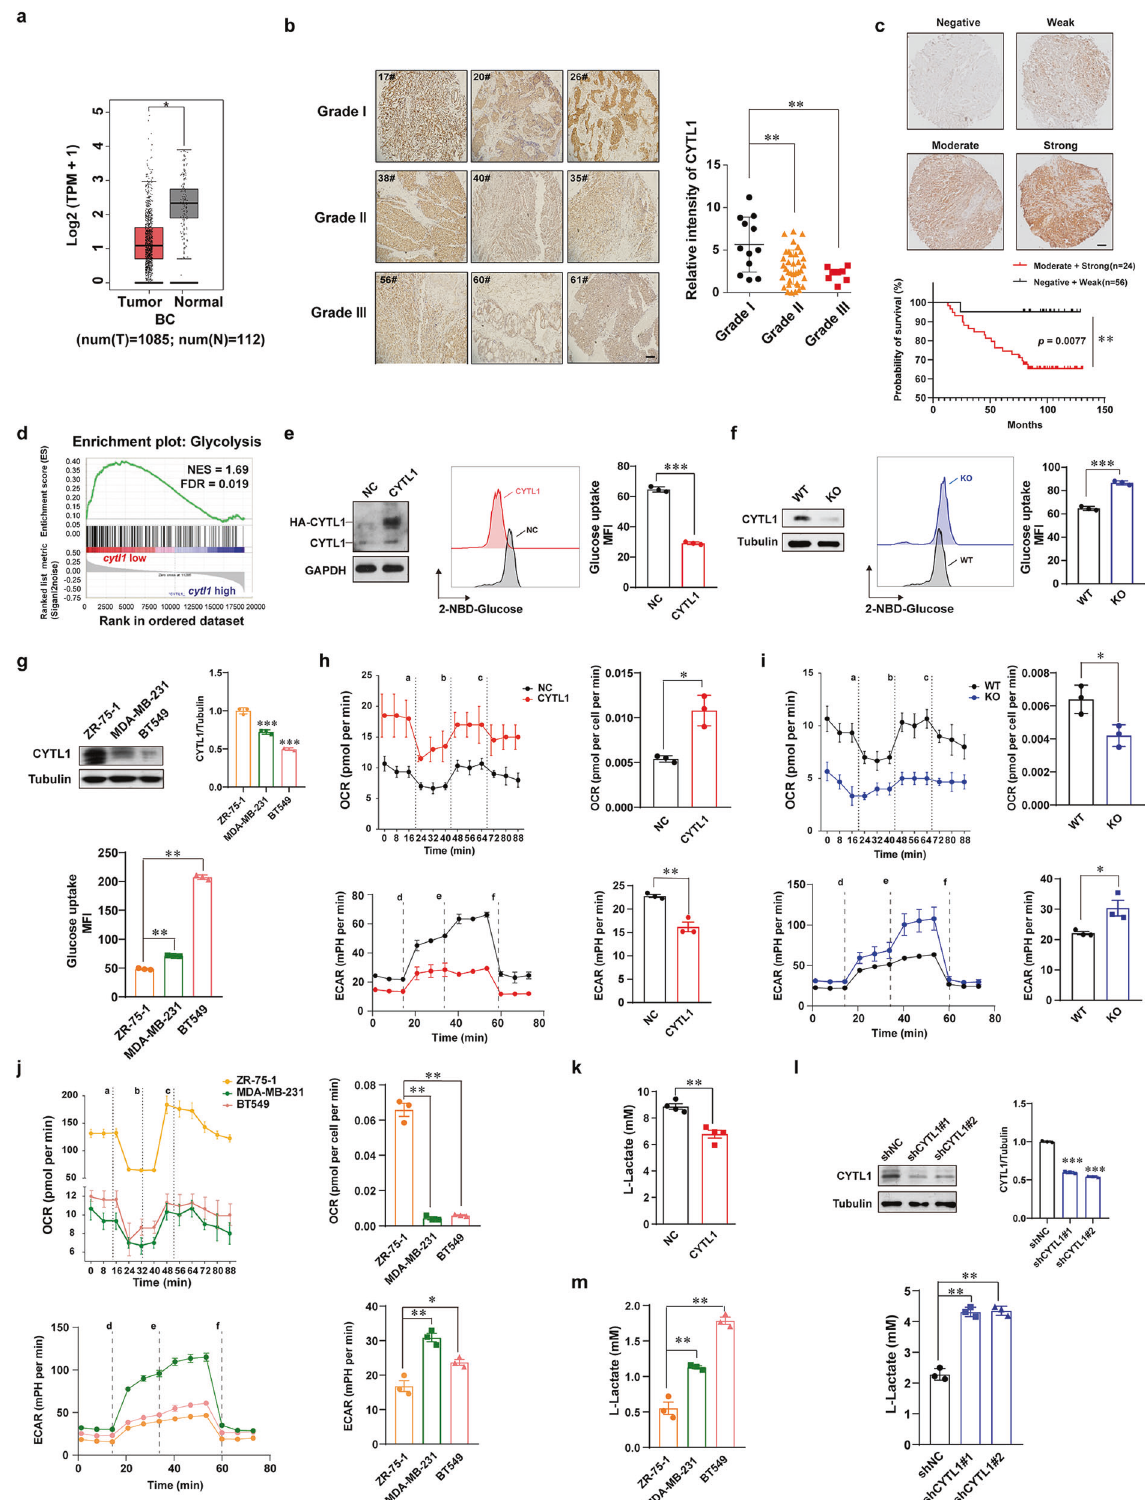
revealed a decreasing trend in cytl1 expression during breast cancer progression (Supplementary Fig. S1b). An immunohisto- chemical (IHC) analysis con fi rmed the negative correlation between CYTL1 protein expression and successive grades of breast cancer malignancy (Fig. 1b). The Gene Expression Omnibus (GEO) database analysis also showed that lower cytl1 expression Signal Transduction and Targeted Therapy (2022)